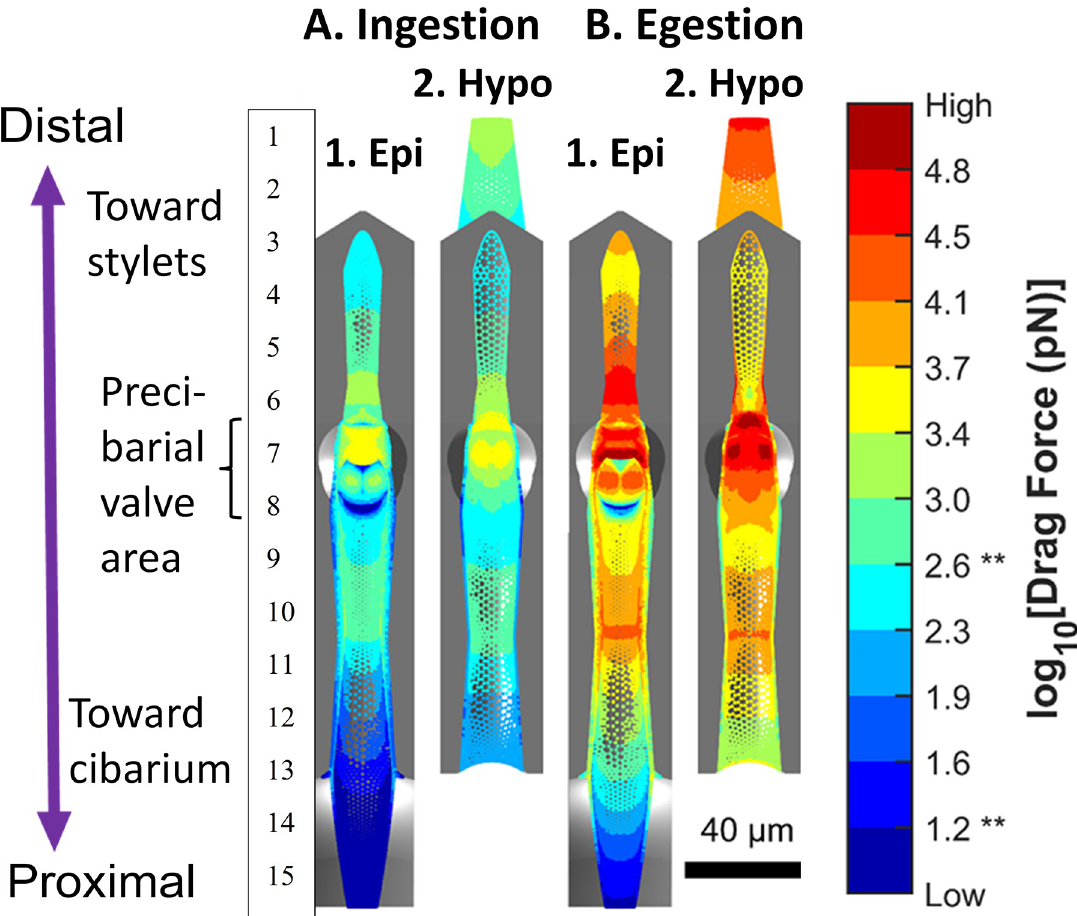
Fig 3. Colormaps of simulated drag forces acting on individually surface-attached bacteria in the G . atropunctata precibarium during A. Ingestion and B. Egestion. Colors representing drag forces (guide to the right of colormap) are plotted within gray 3D models of the two halves of the precibarium, the epipharynx (1. Epi) and hypopharynx (2. Hypo), which are similar to previously described 3D models (Fig 1). Numerals to left of colormap represent specific precibarial locations (see text references). During ingestion, drag forces on both halves of the precibarium are generally lower (bluer) than during egestion (yellow to red). The �� symbols on the numerical colormap guide are references to key drag forces in the results of a microfluidic study [29]. 10 1.2 pN (15.85 pN) is the drag force where less than 1% of individually surface-attached X. fastidiosa cells detached in De la Fuente et al (2007). When the drag forces in that same study were sequentially increased, over 70% of X. fastidiosa detached by the time the drag forces reached 10 2.6 pN (443.8 pN) [29]. The number labels are present to highlight the location of insect anatomy within the precibarium that are further described in text. See White, et al., [20] for full description of each segment of the